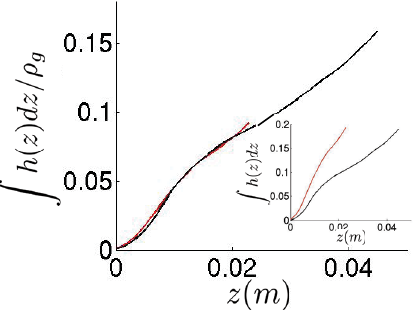
(cid:2) Figure 6. Inset: h ( z ) dz versus z for s = 0 intruder, varying ρ g : sand (red line) or couscous (black line). Higher ρ g (sand) in- creases inertial drag coe ffi cient h ( z ). Main panel: Scaled h ( z ), (cid:2) h ( z ) dz /ρ g versus z for the two grains, collapsing